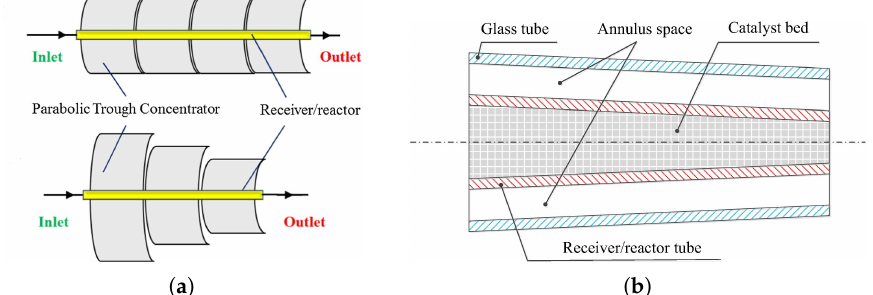
Figure 9. ( a ) Comparison between the traditional solar concentrator structure (top) and new solar concentrator structure (bottom); ( b ) reactor/receiver tube with variable diameter. Reprinted from [114] with permission from